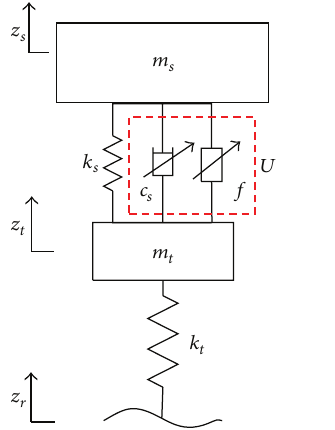
Figure 2: Quarter car model of the proposed active suspension.